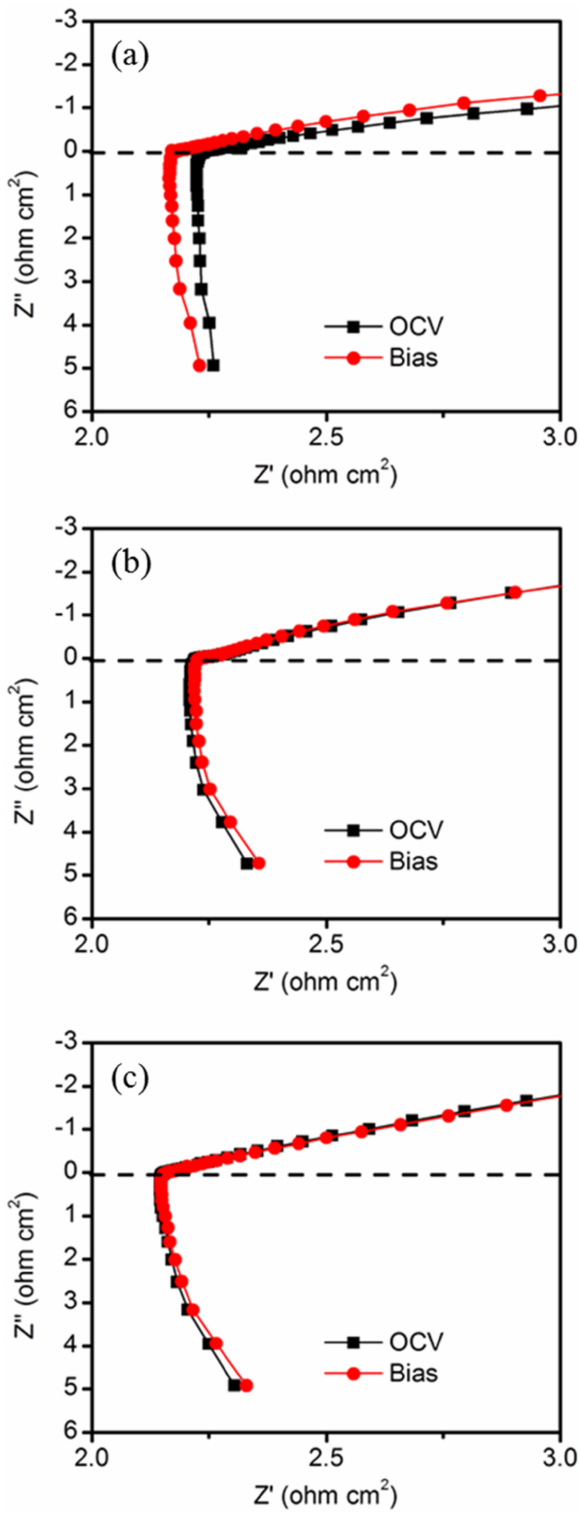
Figure 4. Impedance spectra for ( a ) Sn 0.9 In 0.1 H 0.1 P 2 O 7 /Sn 0.92 Sb 0.08 (OH) 0.08 P 2 O 7 ( b ) Sn 0.9 In 0.1 H